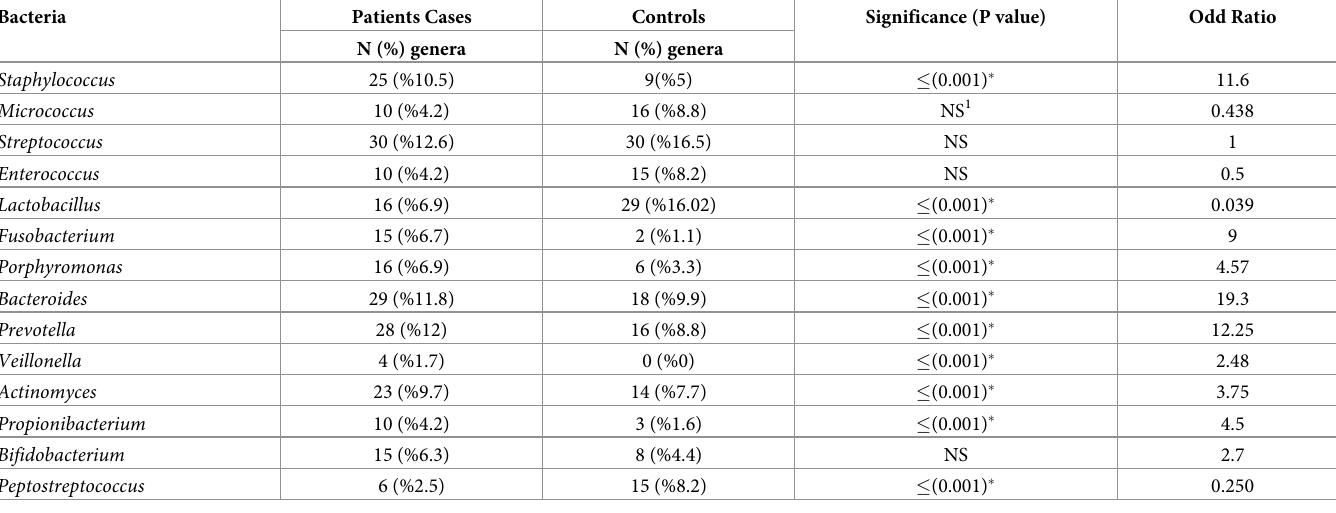
Discussion Host-microbiome interactions play important roles in both progression and regression of sev- eral autoimmune diseases such as Inflammatory Bowel Disease, Rheumatoid Arthritis, Multi- ple Sclerosis, and EAE. Although the main causes of MS are not elucidated yet, the roles of genetic and environmental factors were confirmed earlier. In this regard, one may point toward several environmental factors such as resident microbiota, overweight and obesity, Table 3. Bacterial genera in patient and healthy